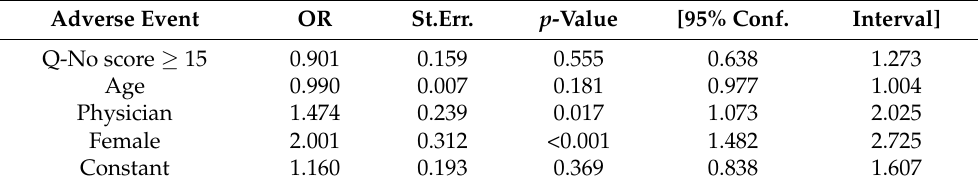
Table 7. Multivariate logistic analysis for adverse event reporting by Q-No score, gender, age, and